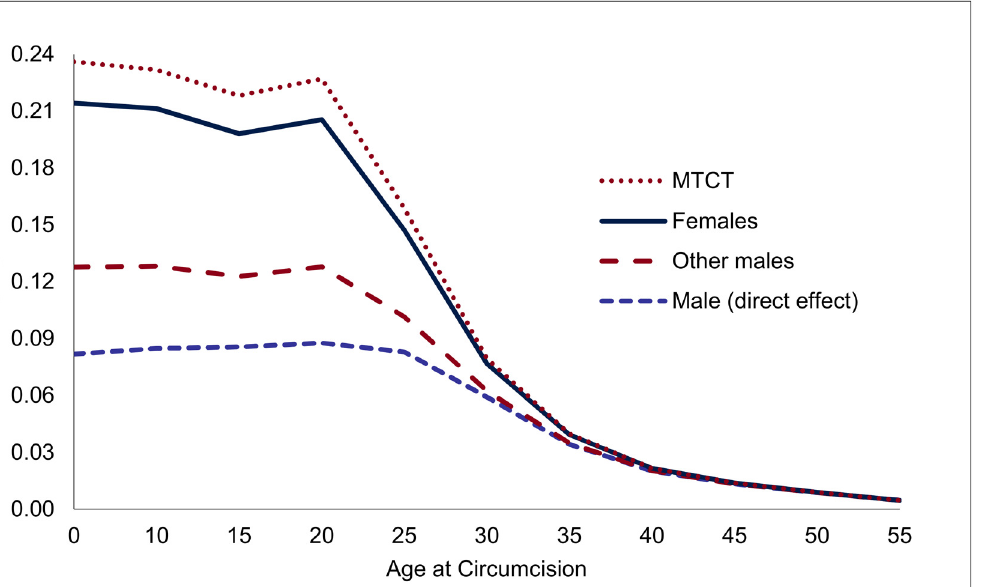
Fig 4. Accumulated effect of one male circumcision on HIV incidence, by age of individual circumcised (HIV infections prevented, in units). Note: Lines are stacked, so that the distance between the lines gives the effect for each group, and the highest line shows the total effect.